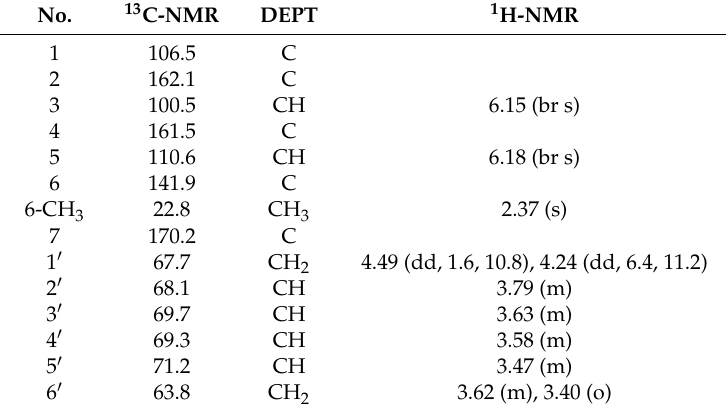
Table 1. 1 H- and 13 C-NMR data of the new compound 1 (in DMSO- d 6 , 400 MHz).